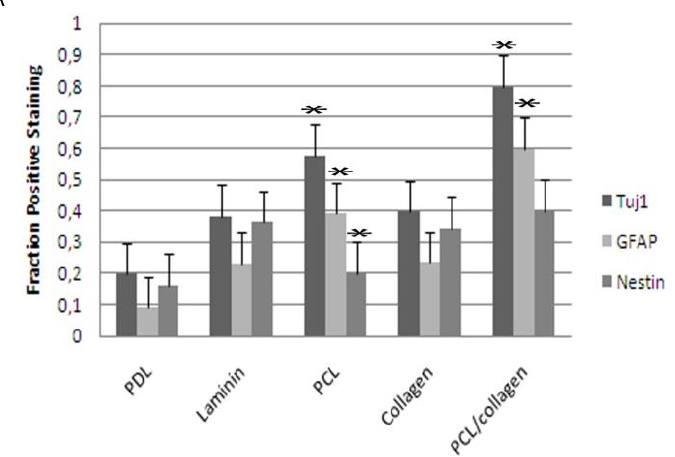
Figure 6. Immunofluorescence analysis of NSCs cultured on various